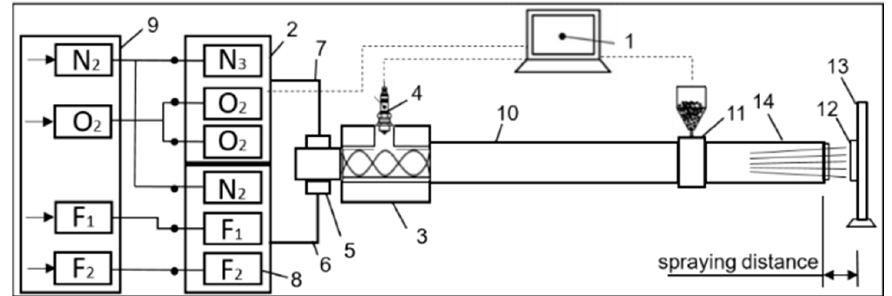
Figure 2. The CCDS2000 setup schematic diagram: 1—controlling computer; 2—distribution company; 3—mixing chamber; 4—spark plug; 5—barrel damper; 6—fuel line; 7—oxygen line; 8—gas valves; 9—gas distribution unit; 10—barrel indicated part; 11—powder feeder; 12—workpiece; 13—manipulator; 14—the barrel muzzle; F 1 —acetylene; F 2 —propane–butane; O 2 —oxygen; N 2 —nitrogen.